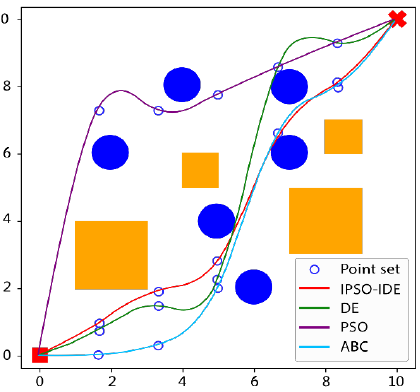
Figure 9. Optimal path results based on different algorithms in environment 2.